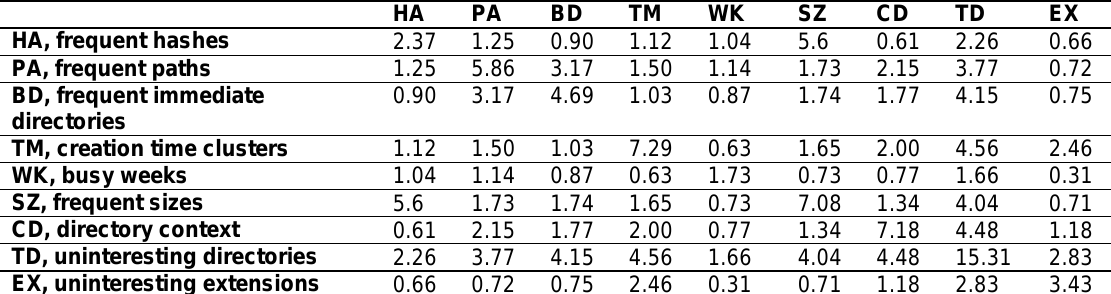
Table 4. Intersection sizes of uninteresting hash sets in our corpus, in millions.